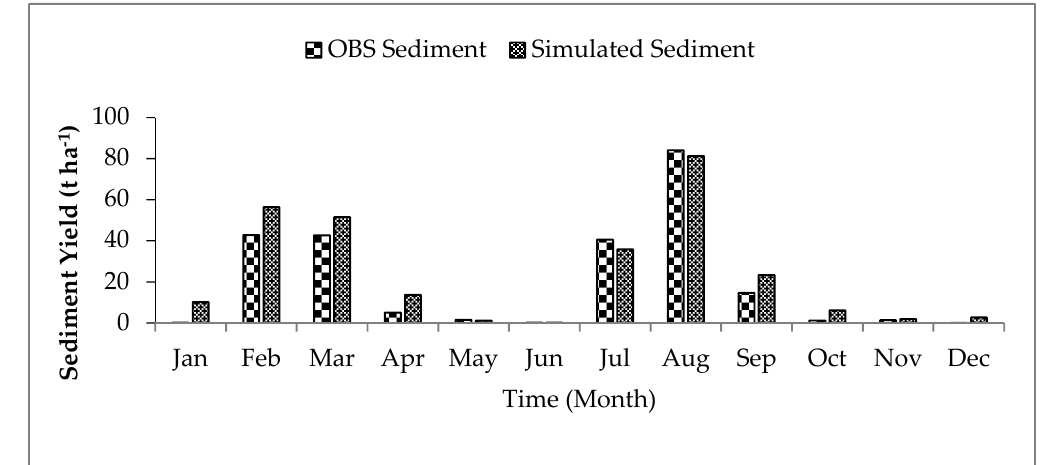
Figure 9. Mean monthly observed and simulated sediment load (1992–2005).